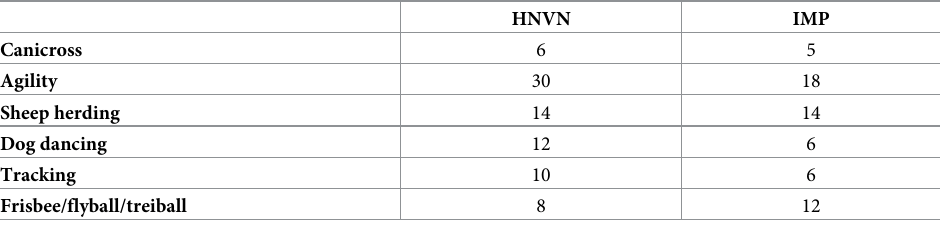
HNVN IMP Canicross 6 5 Agility 30 18 Sheep herding 14 14 Dog dancing 12 6 Tracking 10 6 Frisbee/flyball/treiball 8 12 Frequencies were assessed from the number of dogs from each group that practice the activity at a minimum frequency of once a